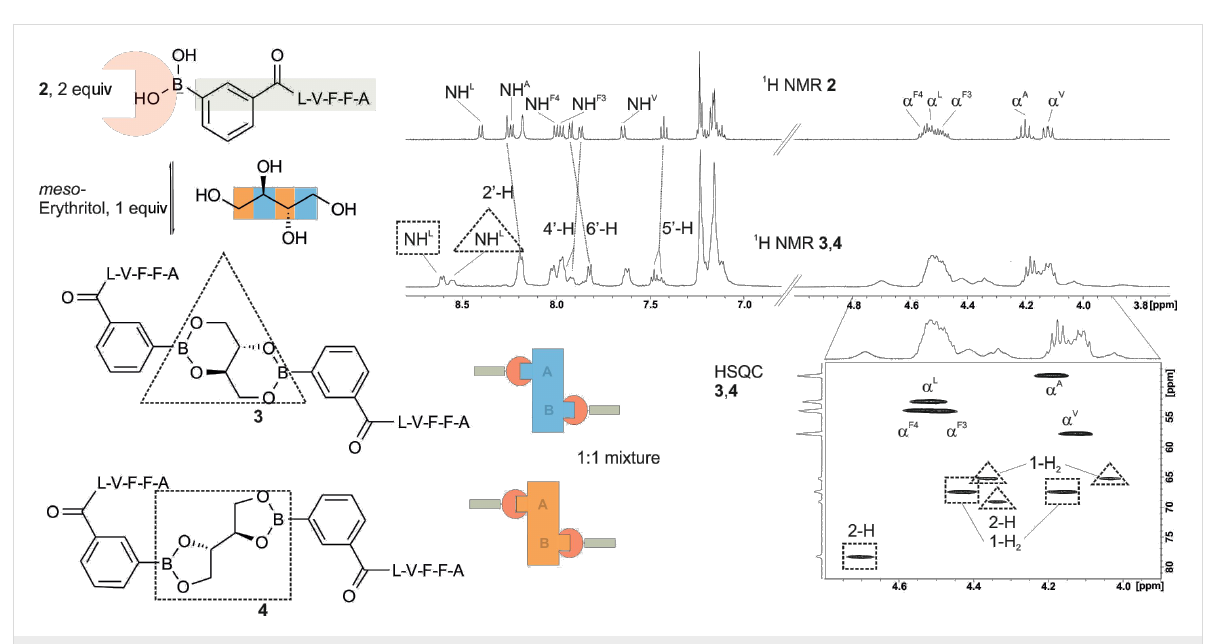
Figure 3: Meso -erythritol is a promiscuous polyol which forms mixtures of esters due to the formation of 5-membered (square, 4 ) and 6-membered (triangle, 3 ) esters. The overlapping resonances in the 1 H NMR spectra of the esters in the region between 4 and 5 ppm are resolved in the HSQC spectrum, where the alpha-carbons are visible below 50 ppm and the CH–OB groups between 65 and 80